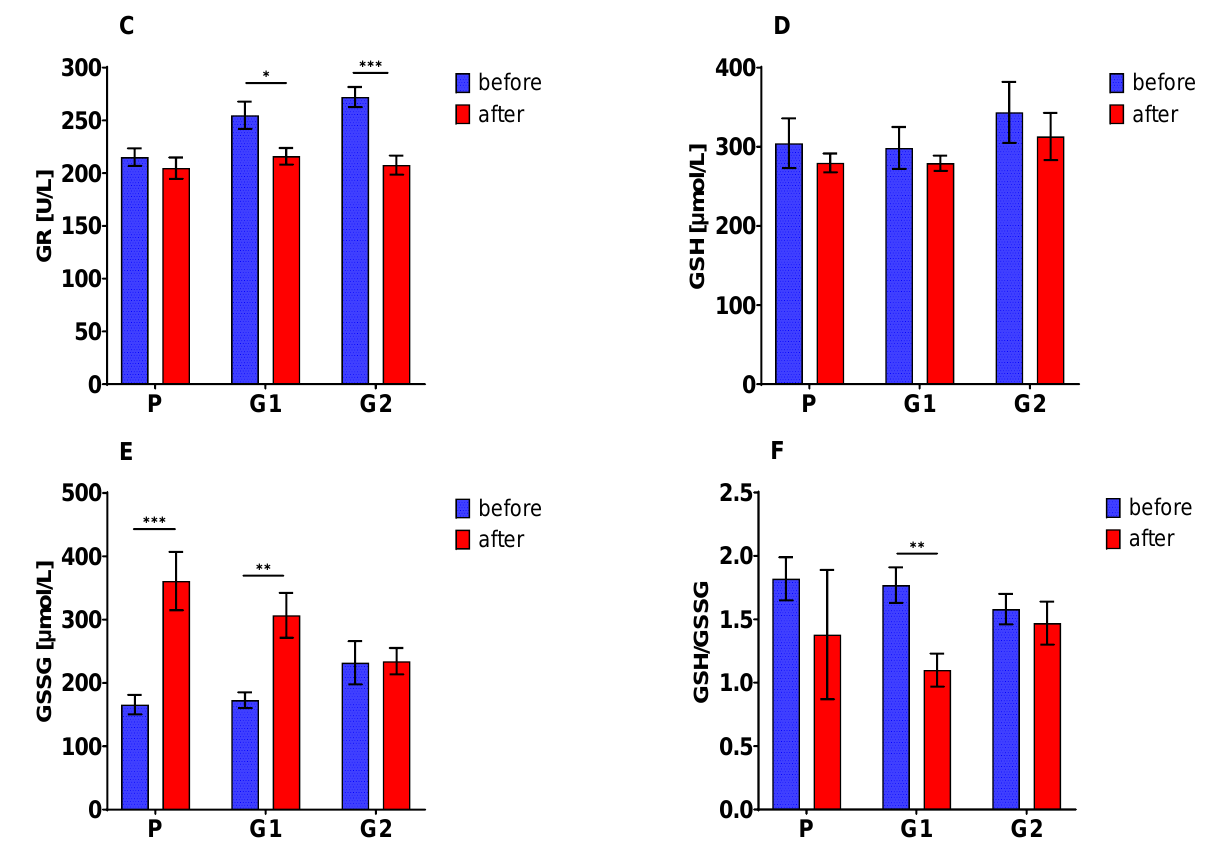
Figure 2. Blood superoxide dismutase (SOD) ( A ), glutathione peroxidase (GPx) ( B ) and reductase (GR) ( C ) activities; serum reduced (GSH) ( D ) and oxidized (GSSG) ( E ) glutathione and GSH to GSSG ratio ( F ). The asterisks (*, **, ***) denote a statistically significant difference after vs. before dietary intervention, set at p < 0.05; p < 0.01; p < 0.001, respectively.